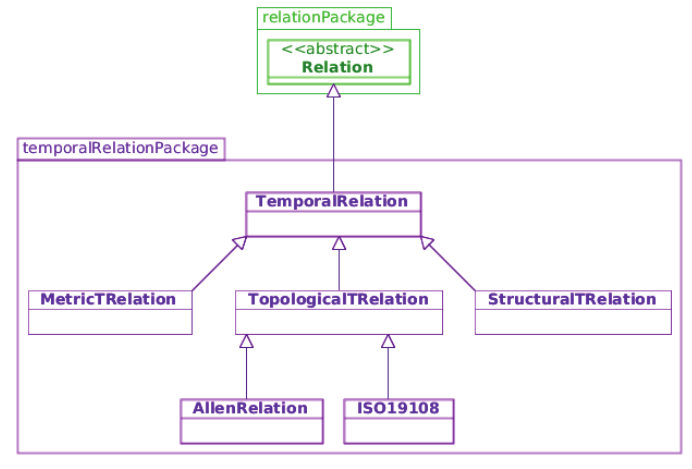
Figure 8: Temporal relation